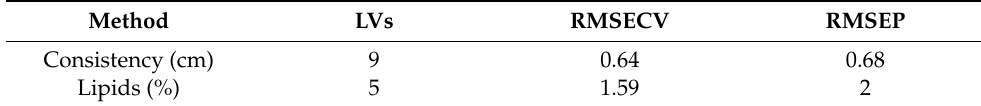
Table 1. Results obtained by PLS Regression.